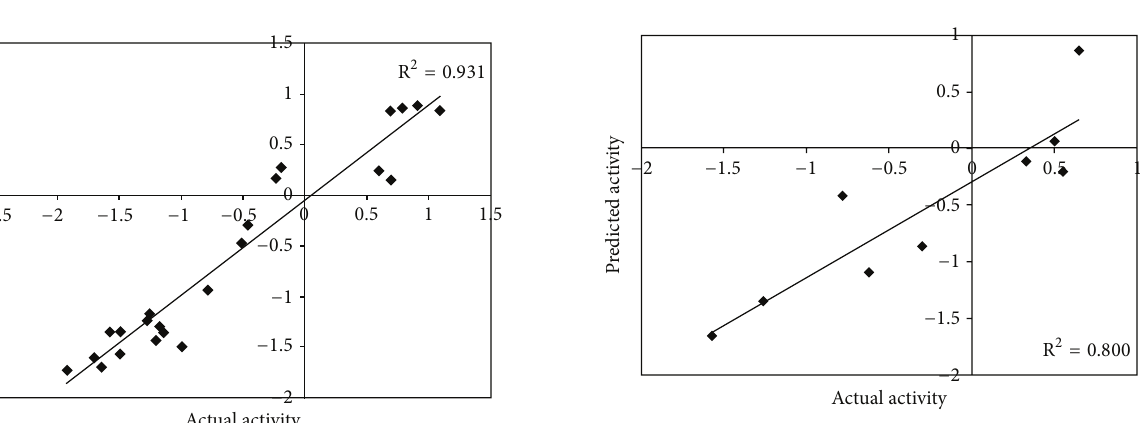
Figure 3: Plot of actual versus predicted values for the training set molecules with the help of FFNN statistical method.